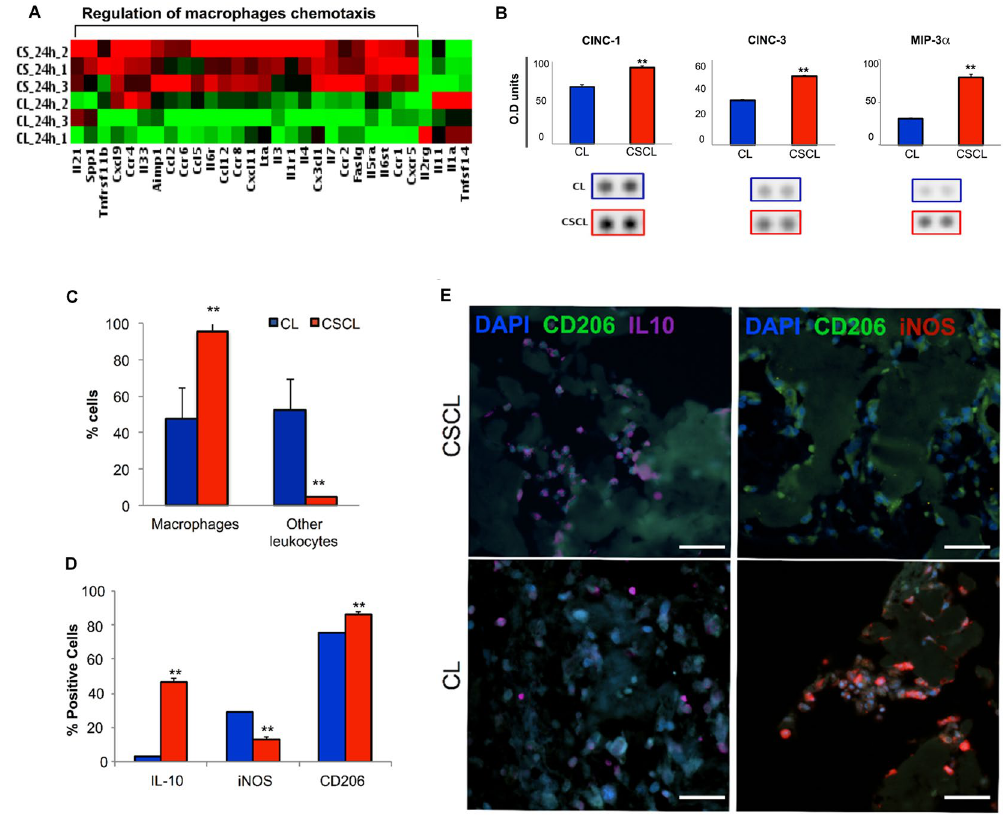
Figure 3. Characterization of infiltrating cells at day 1 post implant. ( A ) Heatmap of differentially expressed genes (DE) between CSCL and CL in in vivo explants from inflammatory cytokines and receptors PCR array. Expression levels of DE genes are displayed as color-coded: red represents over expression while green under- expression. Gene ontology analysis on over-expressed genes in CSCL shows that among the statistically significant pathways involving our data set of proteins, we found “regulation of macrophages chemotaxis” (p-value: 5.9E-18). ( B ) Rat cytokines/chemokines profiling of proteins adsorbed onto CL and CSCL scaffolds 1d after implant. Densitometric analysis. Results are shown as mean of three replicates ± SD. ** p ≤ 0.001. CINC-1, CINC-3 and MIP-3 α revealed different levels of abundance. ( C ) Percentage of macrophages (anti-macrophages + /anti-CD45 + cells) and other leukocytes (CD45 + cells) isolated from explants and assessed by flow cytometry. Graph represents mean values ± SD (n = 3). ( D ) Quantification of immunofluorescence staining for IL-10, iNOS and CD206 positive cells on consecutive sections Graph represents mean values ± SD (n = 10). ( E ) Representative immunofluorescence stained consecutive sections with anti-IL-10 (purple) and anti-CD206 (green) and anti-iNOS (red). The images show presence of macrophages IL-10 + (purple) within the scaffold 1-day post implant (scale bars: 50 μ